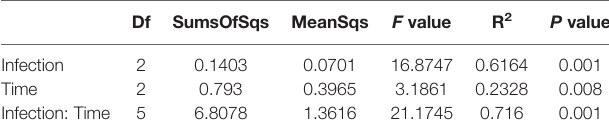
TABLE 2 | The effects of sampling time and PpX-8 on variation in community composition using permutational multivariate analysis of variance (PERMANOVA) with adonis based on Bray –